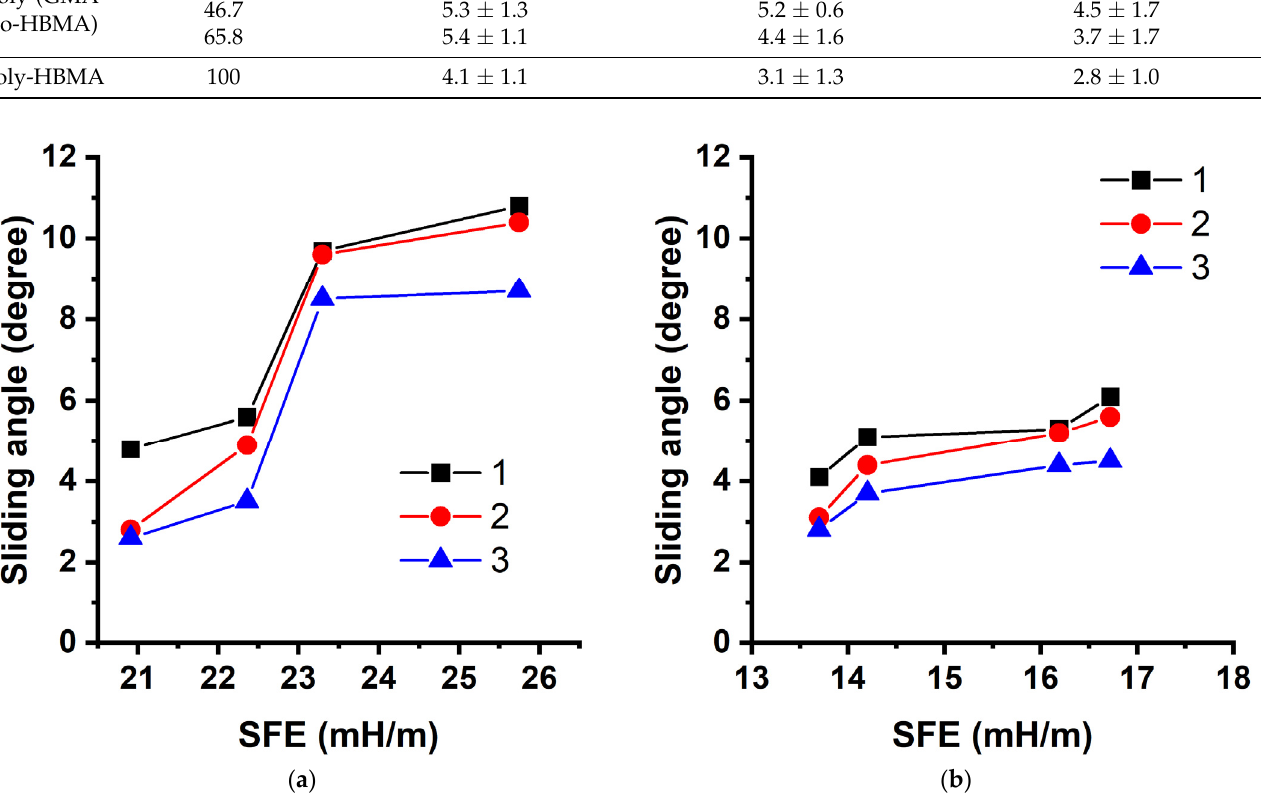
Figure 6. Changes in the roll-off angles of water droplets from the surface of the textured aluminum samples as a function of the surface free energy of the polymer coating at different rates of inclination: ( a ) poly-(TEMA-co-GMA); ( b ) poly-(HBMA-co-GMA): 1—0.37 °/s; 2—0.61 °/s; 3—1.1 °/s. Table 5. Roll-off angle of water droplets from the aluminum surface modified with GMA- and FMA-based copolymers with a changing rate of inclination of the plane to the horizon. surface modified with a polymer coating with the same SFE. This occurred because